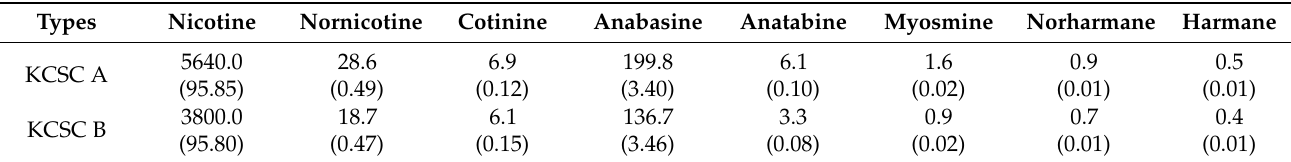
Nicotine and non-nicotine alkaloid contents of the two commercial cigarette brands in South Korea (KCSCs) ( µ g/mL).